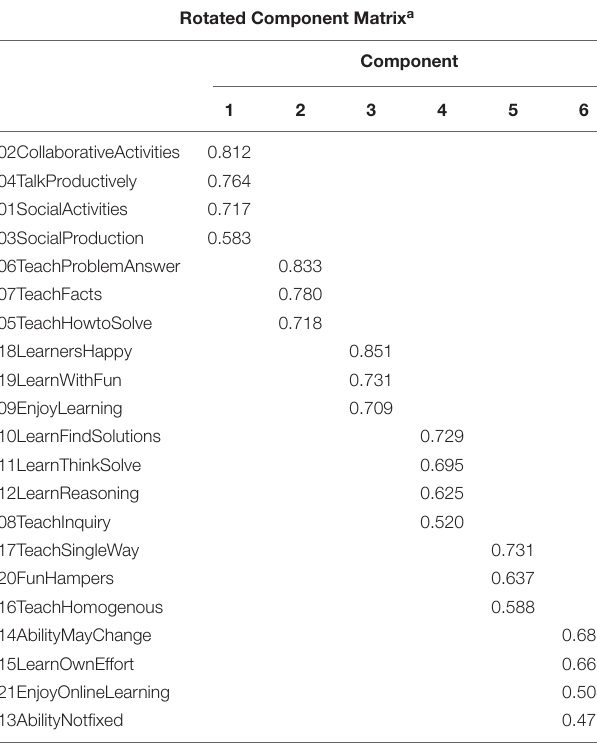
Extraction Method: Principal Component Analysis. Rotation Method: Varimax with Kaiser Normalization. a. Rotation converged in 6